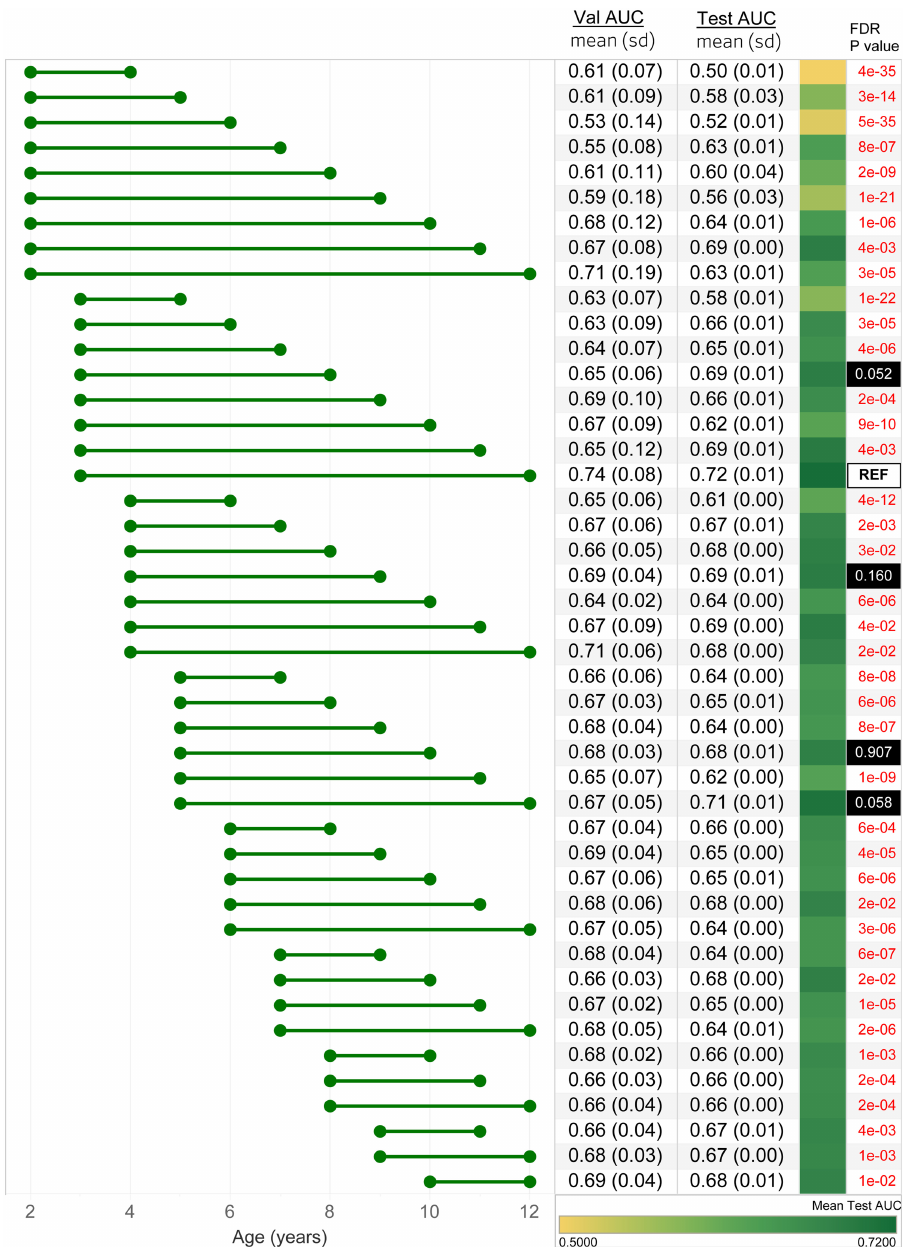
Fig. 5 Performance of the TSF-CNN model to predict pediatric type-2 diabetes (T2D) in a real-world cohort. Different age ranges incorporated in the model are shown with the horizontal bars. Mean and standard deviation of cross-validation (Val) AUCs and test AUCs are shown. The third column represents the model area under the receiver operating characteristic curve (AUC when it is applied to the withheld test set) with a green gradient indicating the accuracy of the prediction. The fourth column indicates the FDR P values of the Delong ’ s test for each AUC compared to the best performing age range, ages 3 – 12, annotated with “ REF ” . Models with a FDR P < 0.05 are shown in